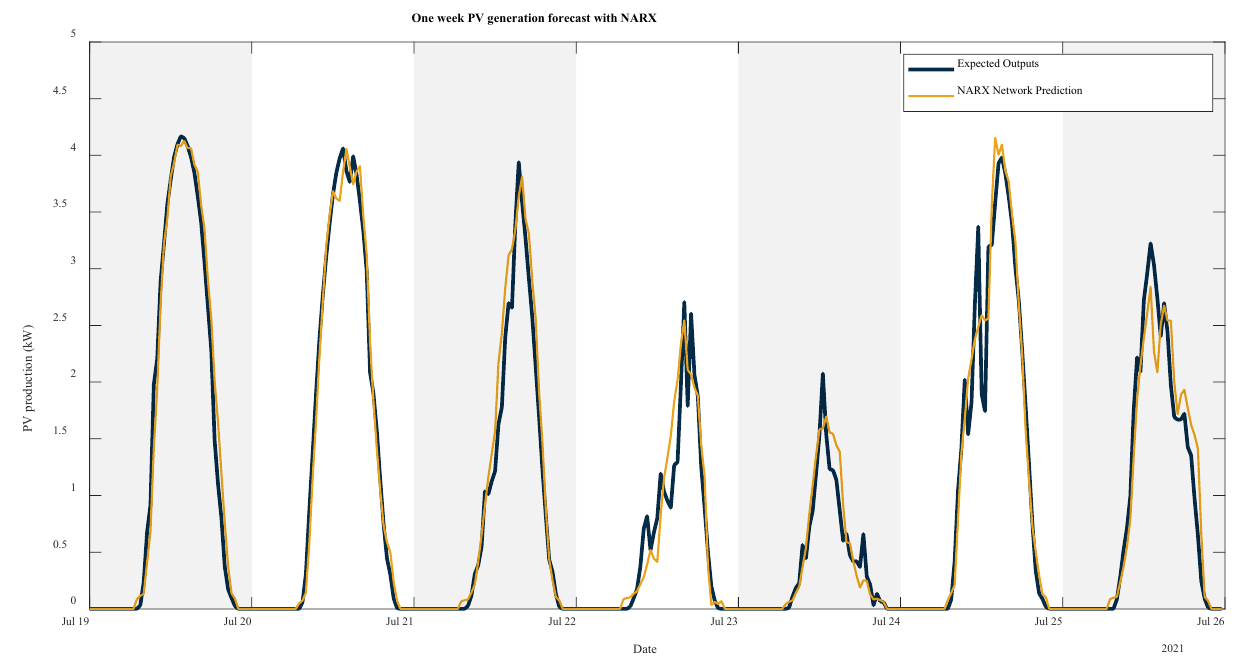
Figure 12. Forecast of PV generation for a week of July with NARX model.